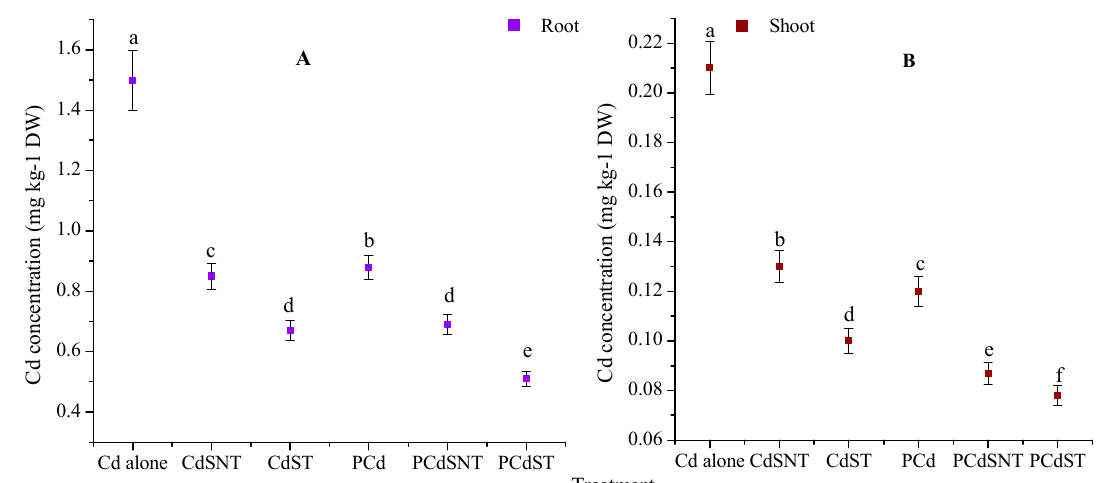
Figure 2. Effect of modified and unmodified rice straw on Cd concentration in the root ( A ) and shoot ( B ). In each group ( A and B ), the lowercase letters indicate a significant difference within different treatments (Tukey’tests, p < 0.001).